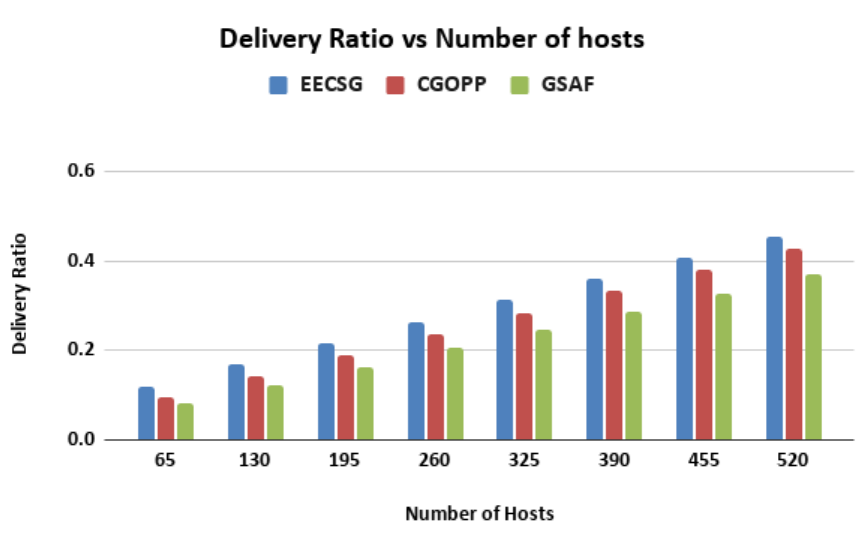
Figure 2. Delivery ratio vs. number of hosts.